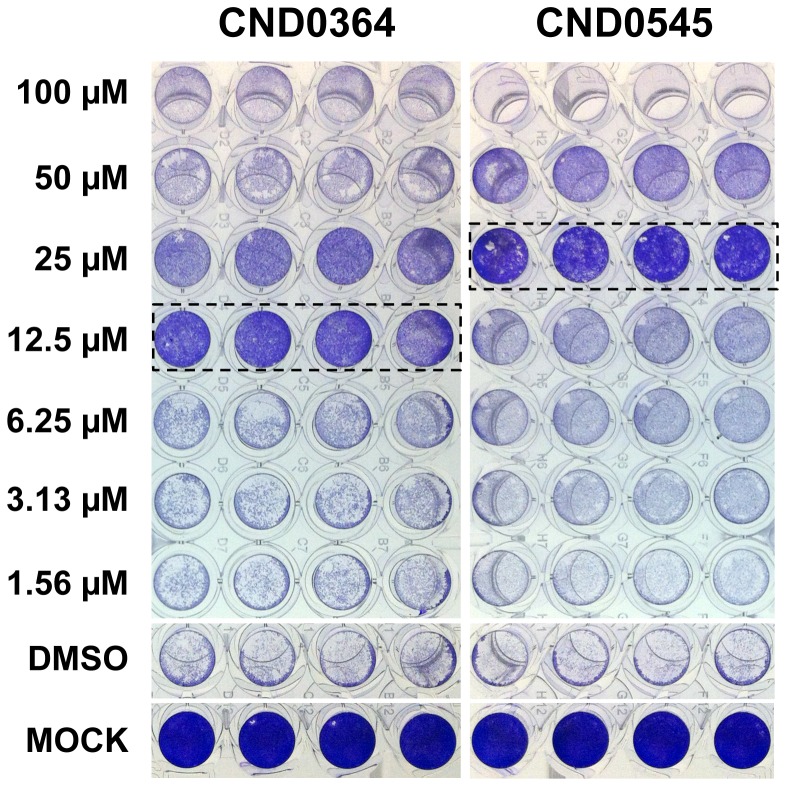
Virus neutralization assay.Confluent monolayer of HuH-7 cells were infected with 50 pfu CHIKV-118-GFP in the presence of compound CND0364 or CND0545 at various concentrations for 72 hrs, and then stained with 0.1% crystal violet solution to observe clearance of the cell monolayer caused by virus infection. Dotted boxes indicate concentration of compounds that exhibit protection against CHIKV-induced CPE. (DMSO – infection control, MOCK – negative control).